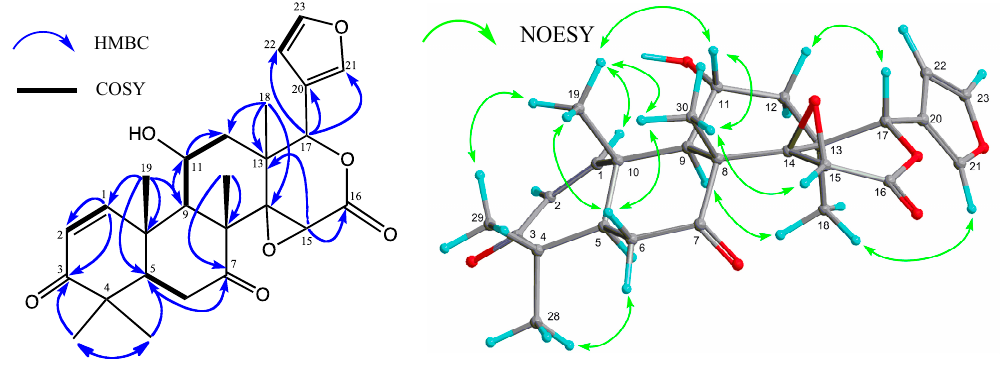
Figure 2. Key HMBC, COSY, and NOESY correlations for carapanolide J ( 1